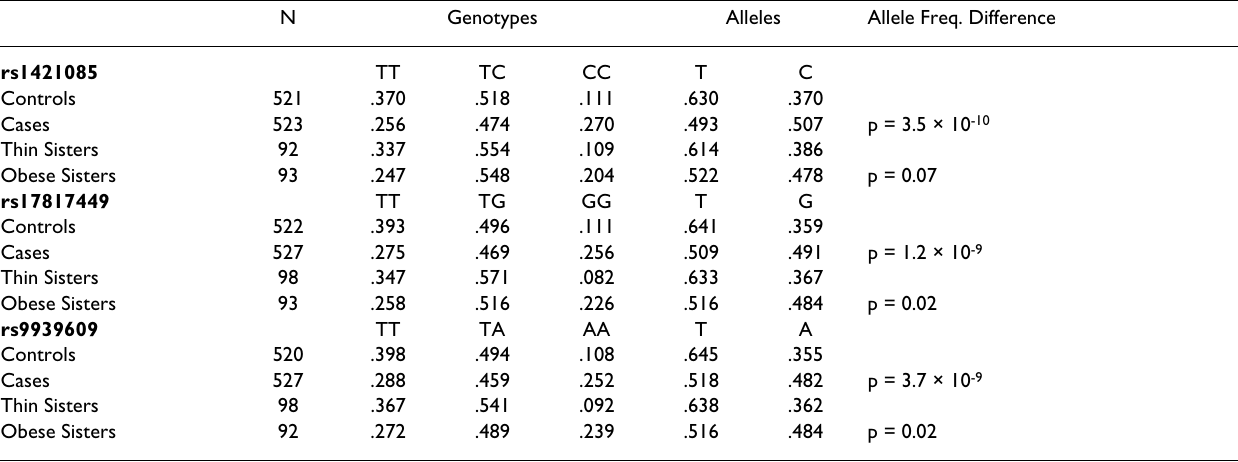
Table 2: Genotype and allele frequencies of three FTO SNPs in cases/controls and discordant sisters. Significance for case-control and thin-obese sister allele frequency comparisons are given in the right column. Genotype comparisons are presented in Table 3. N Genotypes Alleles Allele Freq.